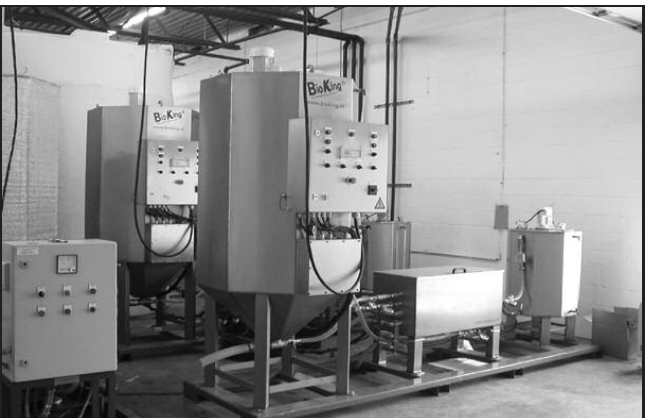
Figure 4. Production Equipment at Mason